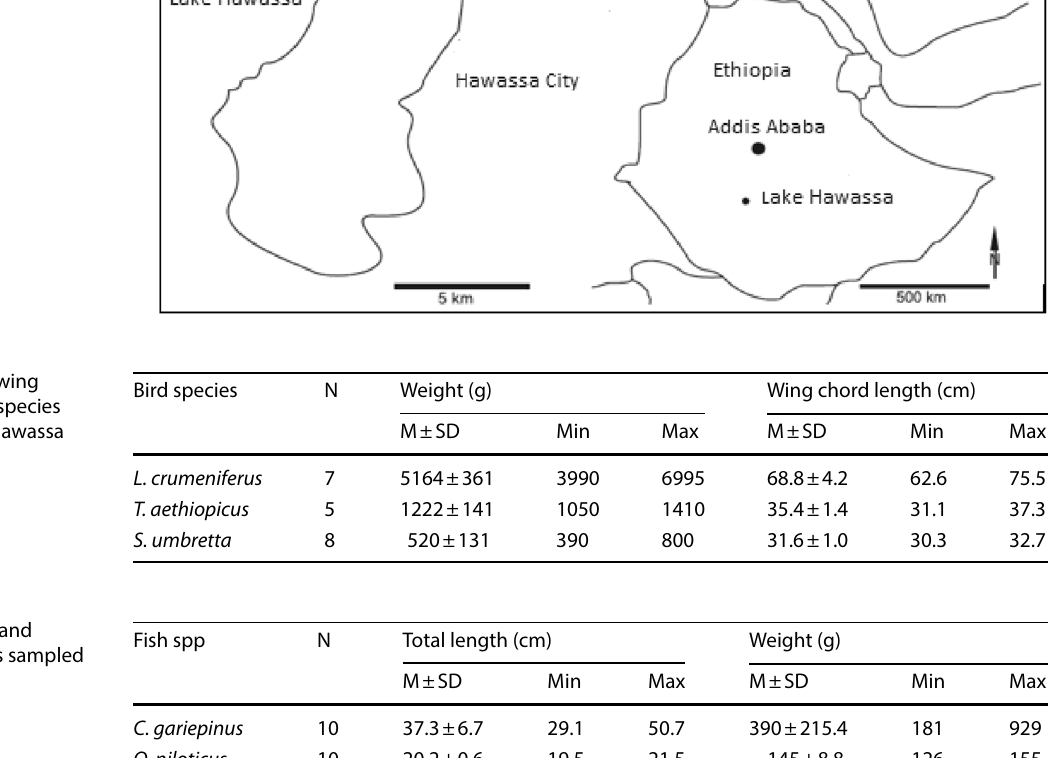
Fig. 1 Maps of Lake Hawassa (modified from Dsikowitzky [26])